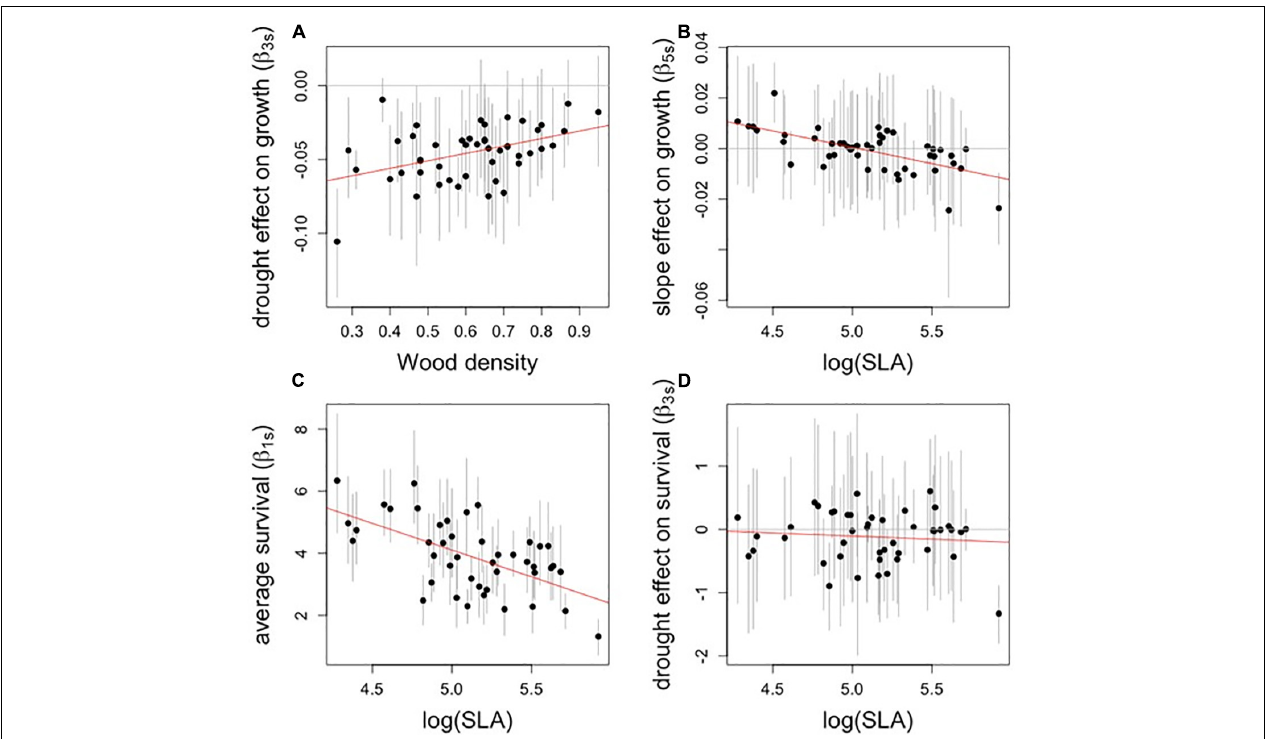
FIGURE 4 | Relationships between traits ( x -axis) and select species-specific estimates of model parameters ( y -axis). Each point represents the median estimate of one species’ parameter, and bar represent credible intervals. All relationships shown were significantly different from zero except for panel (D) . (A) Drought effect (growth model) vs. wood density. (B) Slope effect (growth model) vs. SLA. (C) Average survival (survival model) vs. SLA. (D) Drought effect (survival model) vs. SLA. Note that SLA is